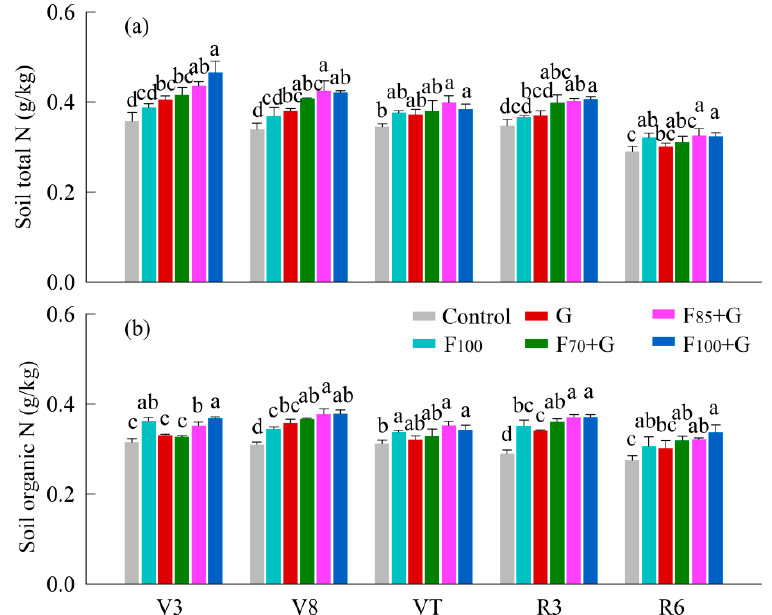
Figure 4. Changes of soil ( a ) total N and ( b ) organic N in the 0–20 cm soil layer during maize growth. Data are mean ± standard error (vertical bars, n = 4). Different letters above columns at each harvest indicate statistical differences between treatments by LSD test ( p < 0.05). V3 and V8 (the third and eighth leaf fully expanded, respectively), VT (tasseling), R3 (milk), and R6 (physiological maturity). Control, no fertilization; F 100 , recommended inorganic fertilization alone; G, green manure incorporation alone; F 70 + G, F 85 + G, and F 100 + G are 70%, 85%, and 100% of F 100 plus G, respectively.